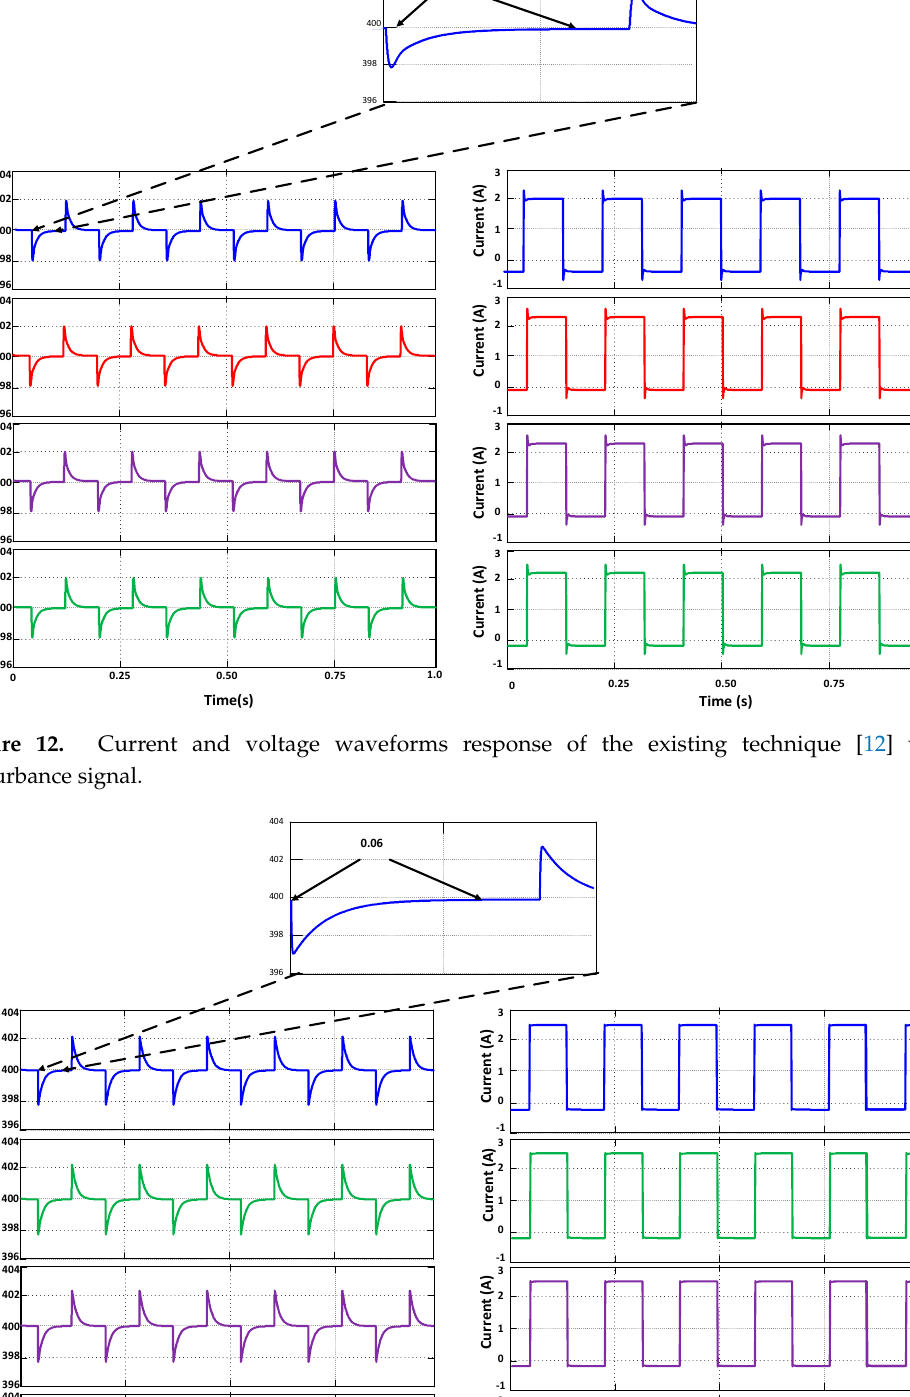
Time(s) Figure 14. Current and voltage waveforms response of the proposed technique with disturbance signal.